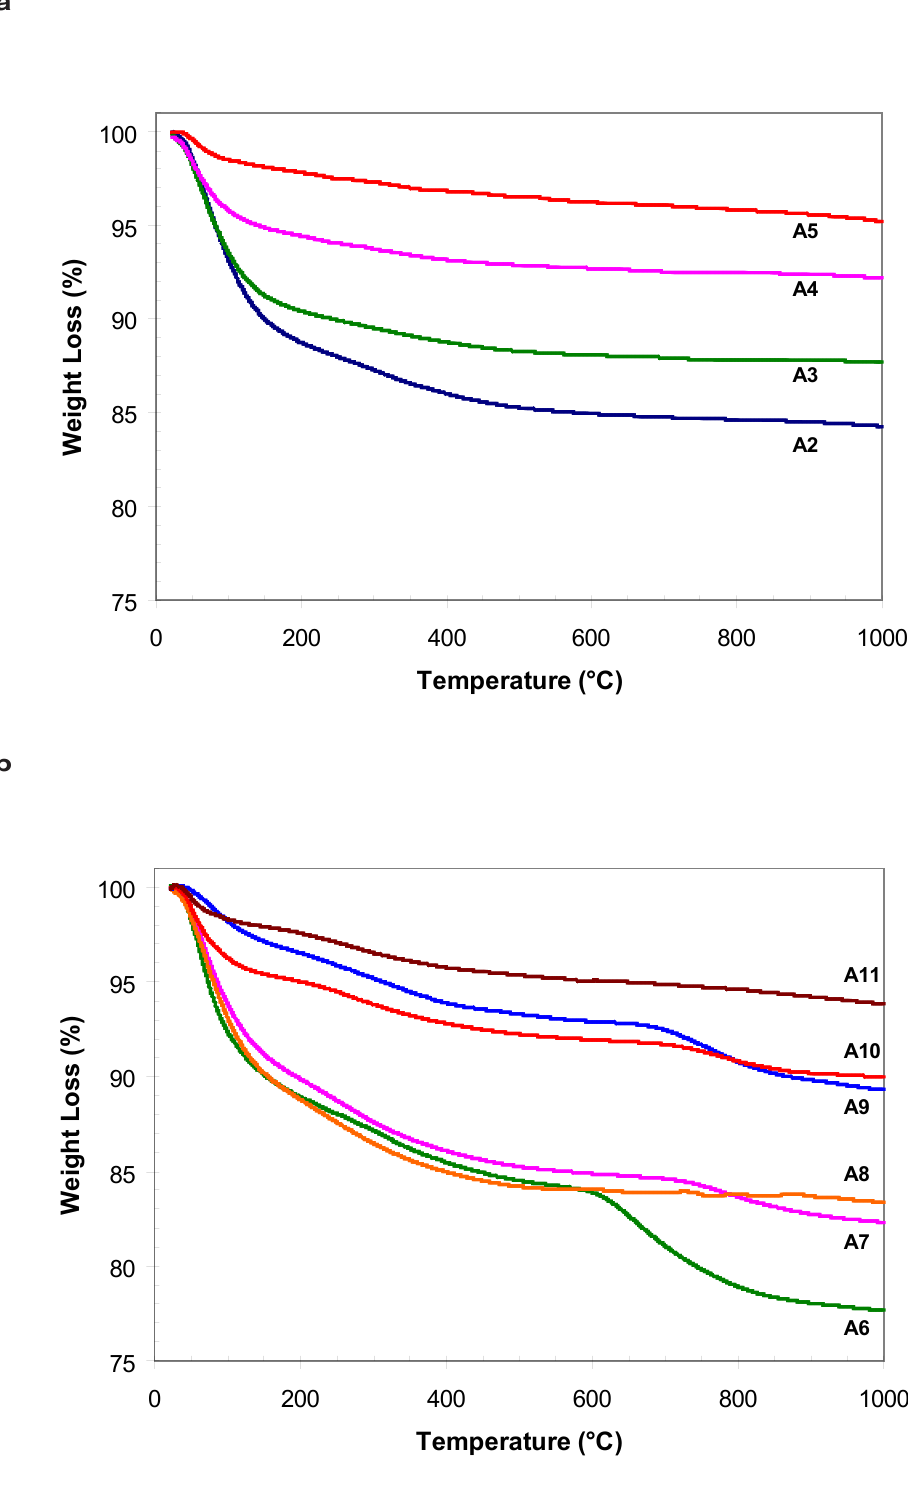
Figure 6. TG analysis of a) calcined and b) acid-treated